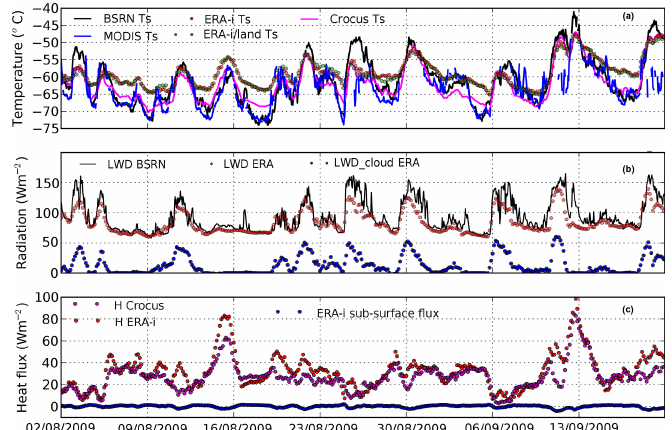
Figure 8. (a) Comparison between different observations of surface temperature at the South Pole: BSRN T s (solid black curve), Crocus T s (solid pink curve), ERA-i T s (red point), LST MODIS (solid blue curve) and ERA-i/land T s (green point). (b) Comparison between thermal radiations: BSRN LW down (solid black curve), ERA-i LW down (red point) and ERA-i LW down_cloud (blue point). ERA-i LW down_cloud was obtained by the difference between ERA-i LW down and ERA-i clear-sky LW down . (c) Comparison between turbulent fluxes of sensible heat: Crocus H (violet point), ERA-i H (red point) and ERA-i sub-surface flux (blue point). Published by Copernicus Publications on behalf of the European Geosciences